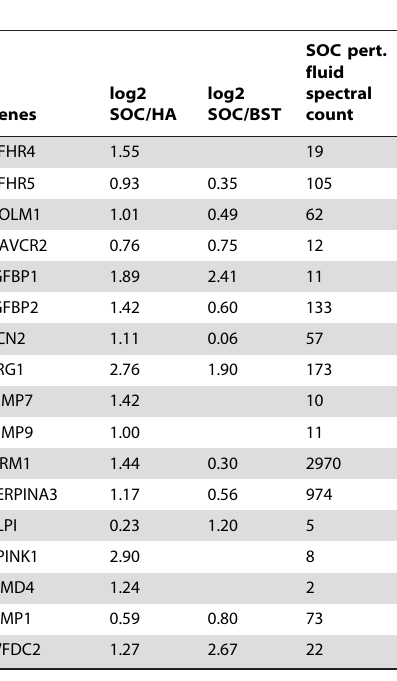
Table 3. Proteins up-regulated in both serum and peritoneal fluid.